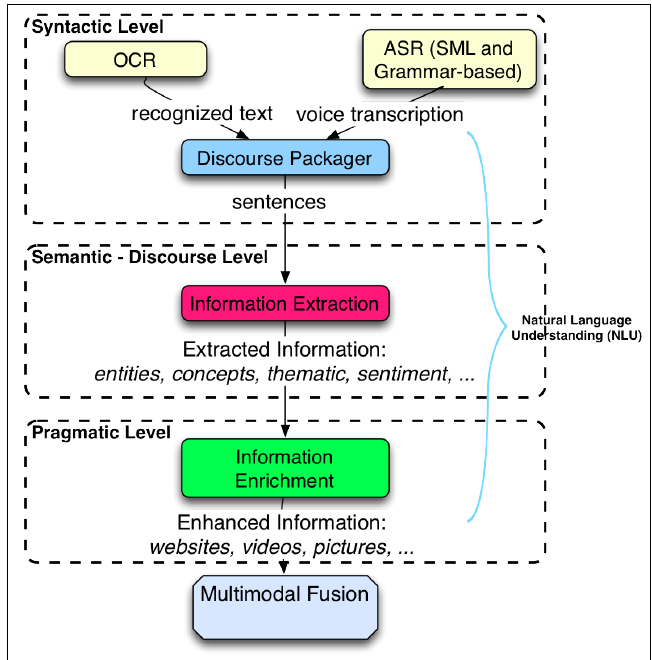
Figure 4. General overview of the information flow inside the augmented robotic dialog